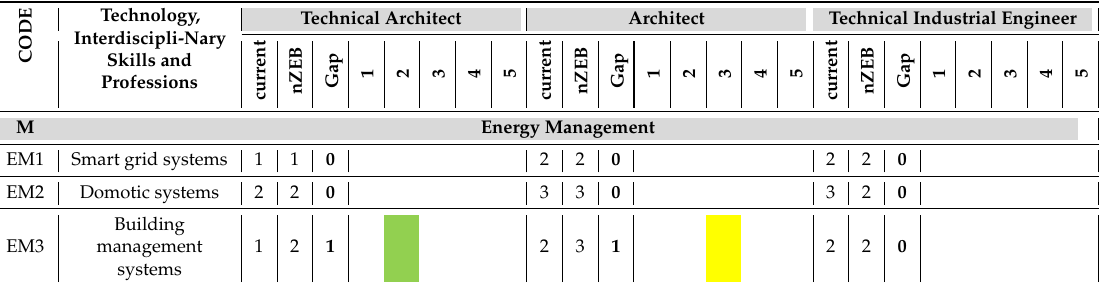
Table 5. PROF/TRAC skills mapping result for Spain,